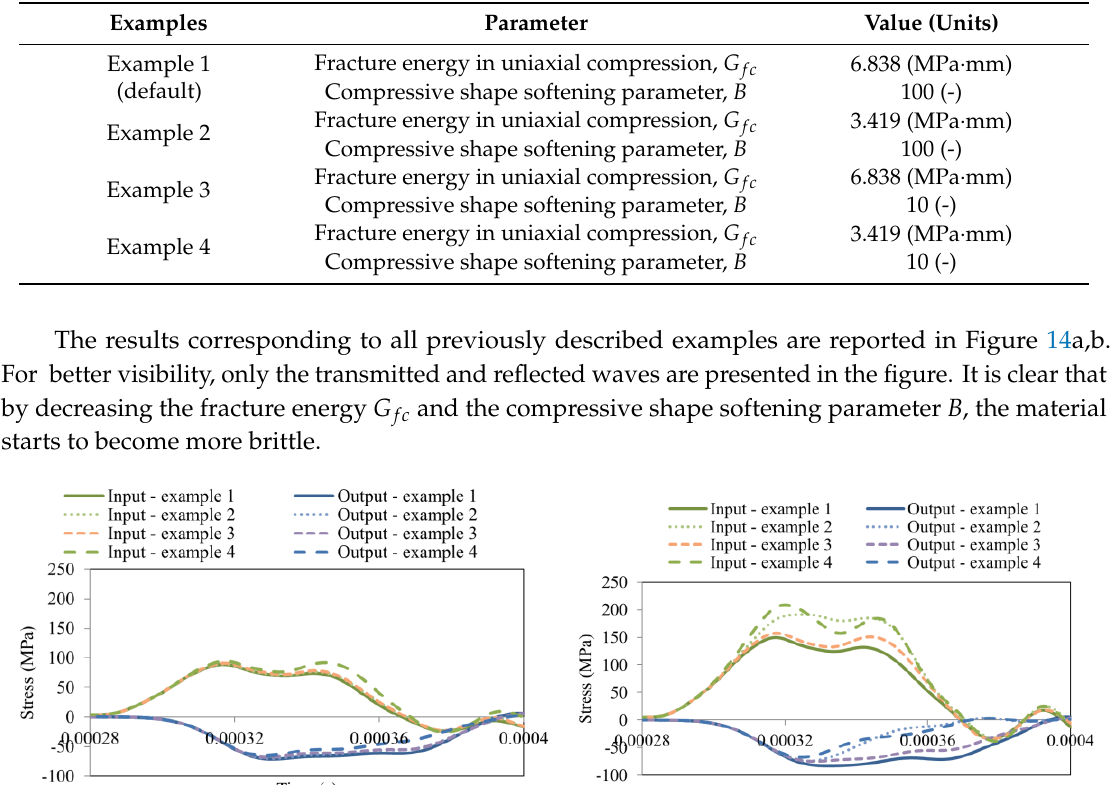
Table 5. Main parameters used to predict the fracture energy sensitivity.